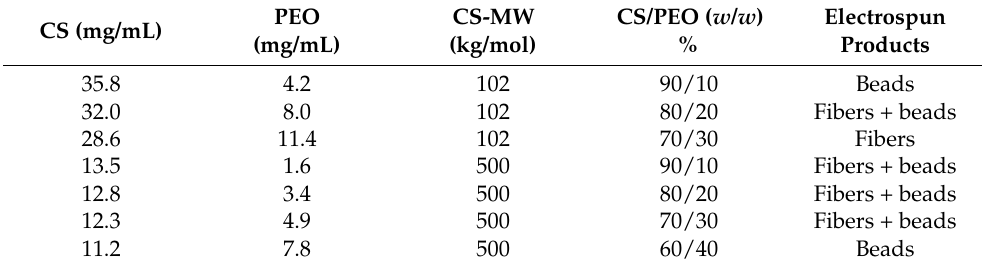
Table 2. Electrospun blends of chitosan having different molecular weights with powdered PEO (1000 kg/mol) added [52].